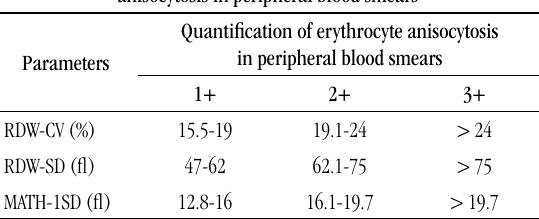
anisocytosis in peripheral blood smears Quantification of erythrocyte Parameters